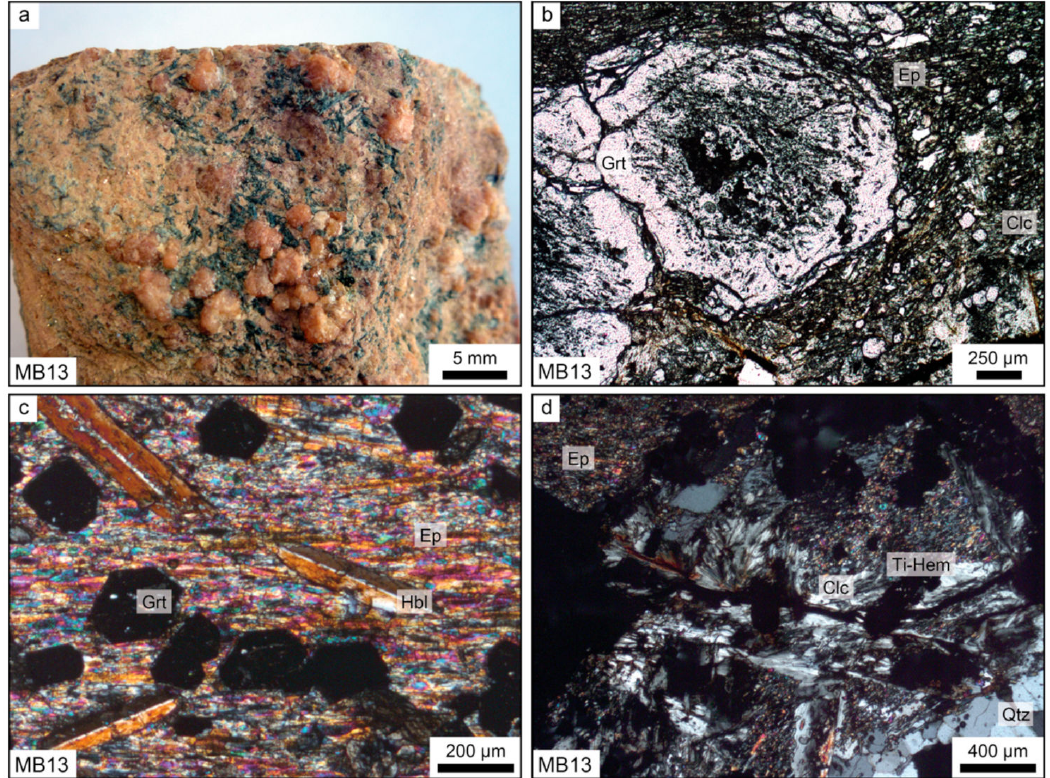
Figure 5. Late brittle fracture sample MB13. ( a ) Hand specimen showing mainly spessartine (orange), Mn-bearing clinochlore and hornblende (green) and quartz. ( b ) Plane polarized light (PPL) photomicrograph with euhedral spessartine (Grt), Mn-rich epidote (Ep) and Mn-bearing clinochlore (Clc) assemblage. ( c ) Crossed-polarized light (XPL) photomicrograph with secondary spessartine (Grt) and hornblende (Hbl) overprinting the metamorphic foliation underlined by Mn-rich epidote (Ep). ( d ) XPL photomicrograph showing Mn-rich epidote (Ep), Mn-bearing clinochlore (Clc), Ti-hematite (Ti-Hem) and quartz (Qtz)